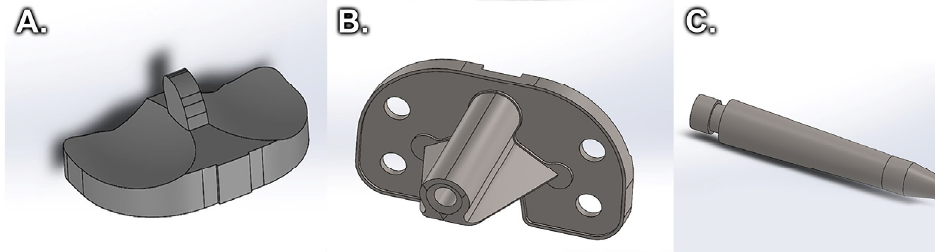
Figure 4. Tibial prosthesis components: ( A ) Polyethylene insert, ( B ) Tibial component, ( C ) Tibial stem.